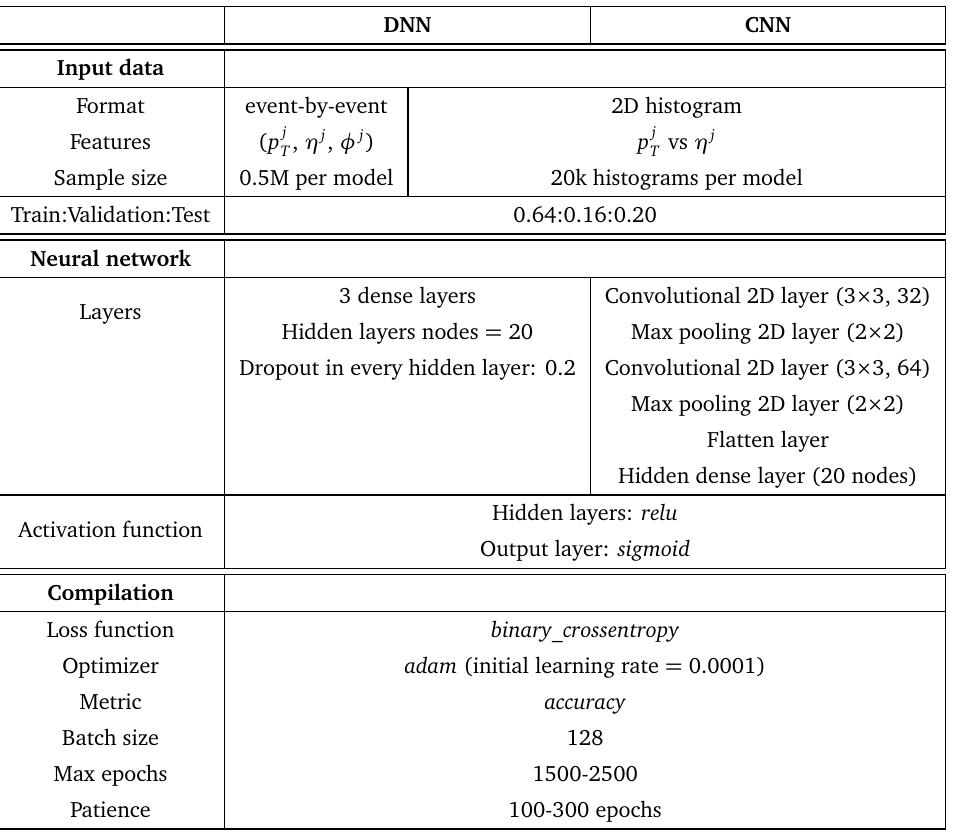
Table 2: ML algorithms specifications. For the CNN case, we denote ( n × m , l ) , or ( n × m ) , a layer with a n × m kernel dimension, and l nodes in each convolutional